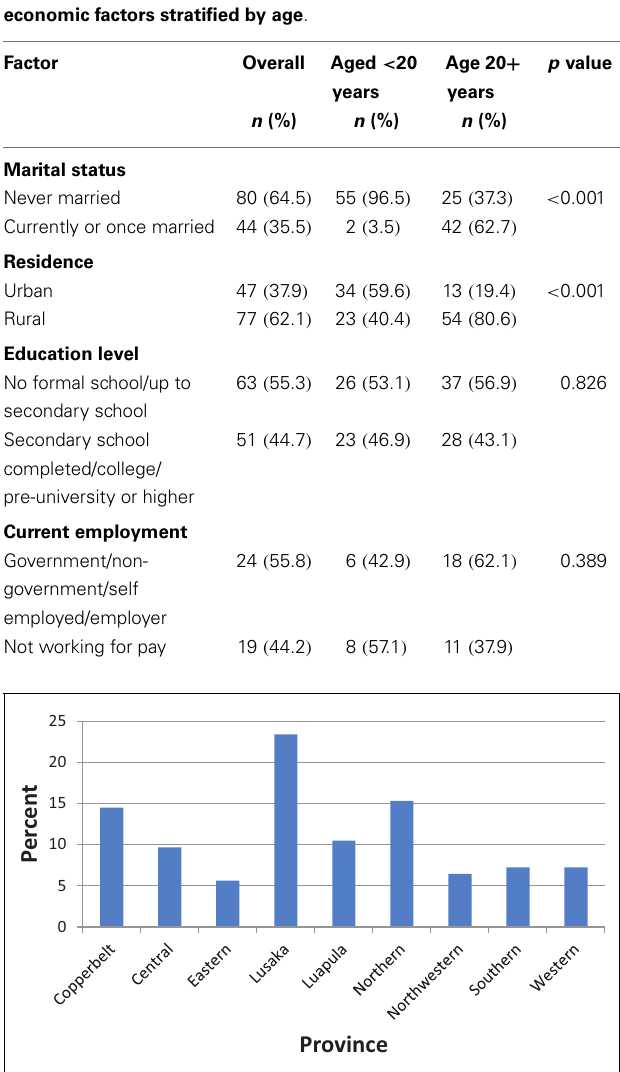
Table 1 | Distribution of participants by socio-demographic and